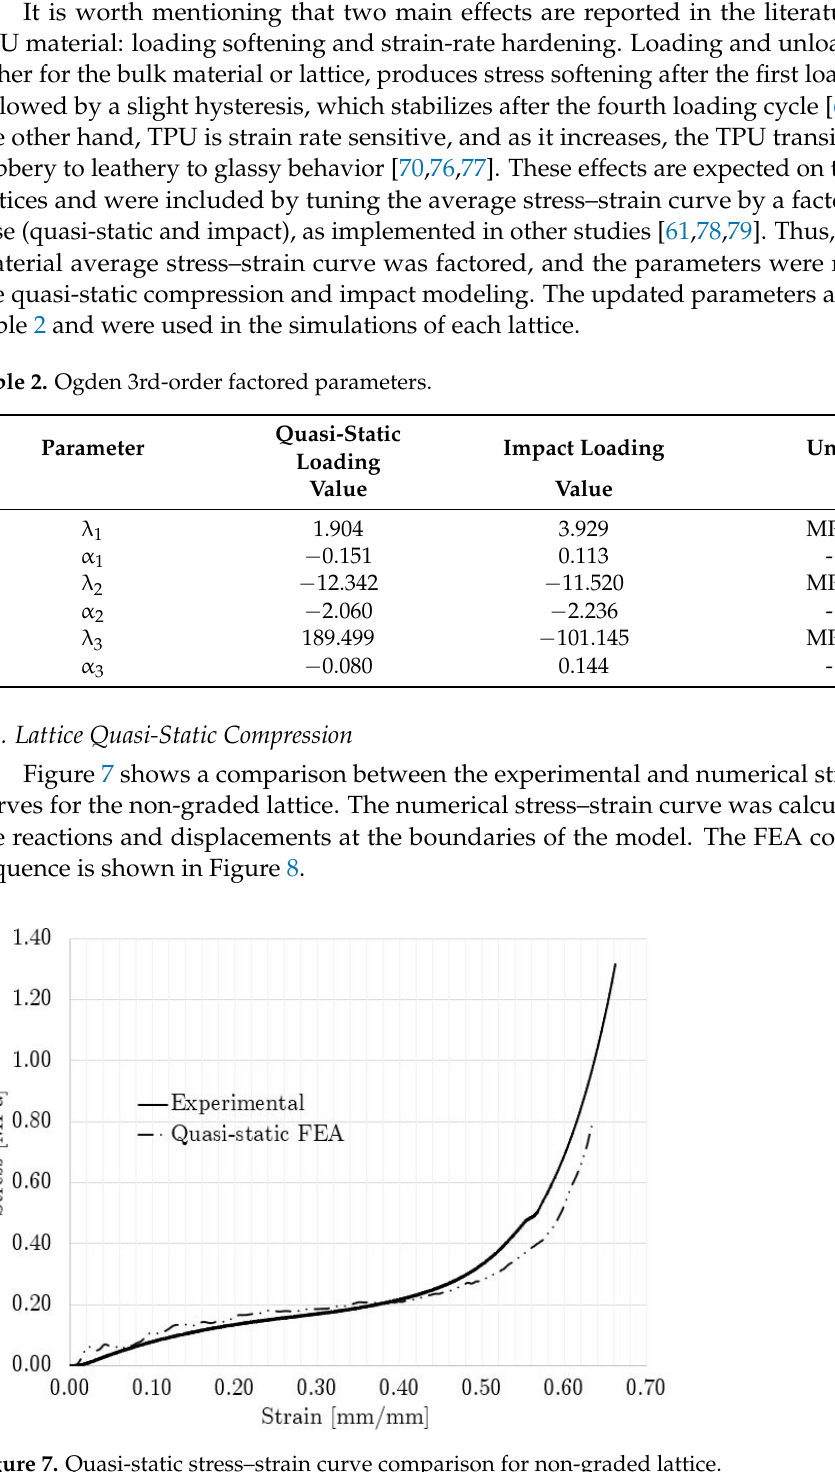
Figure 8. Quasi ‐ static compression sequence for non ‐ graded lattice. The similarity of the quasi ‐ static compression curves displayed in Figure 7 was veri ‐ fied by the FEA model and the fitting of the factored material model parameters. The dis ‐ crepancies between the experimental and numerical results could be attributed to the as ‐ sumptions on the boundary conditions. For instance, the numerical work assumed ideal conditions with friction coefficients from the literature, while the printed lattices might have had geometrical deviations, which could have led to local discrepancies in the fric ‐ tion conditions. Nonetheless, by integrating both curves in Figure 7, the calculated ab ‐ sorbed energy at 0.635 mm/mm differed only by 7% between the experimental and nu ‐ merical results, which validated the non ‐ graded quasi ‐ static compression model. 10 mm